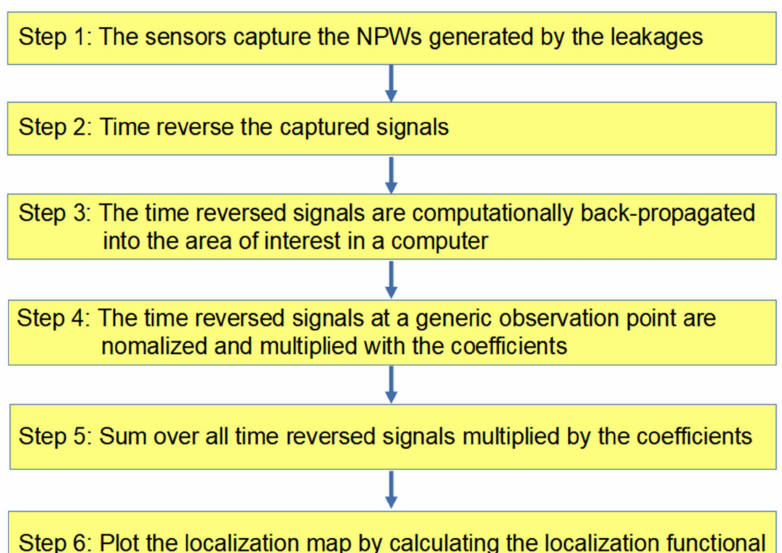
Figure 2. The diagram of signal processing based on the proposed method.